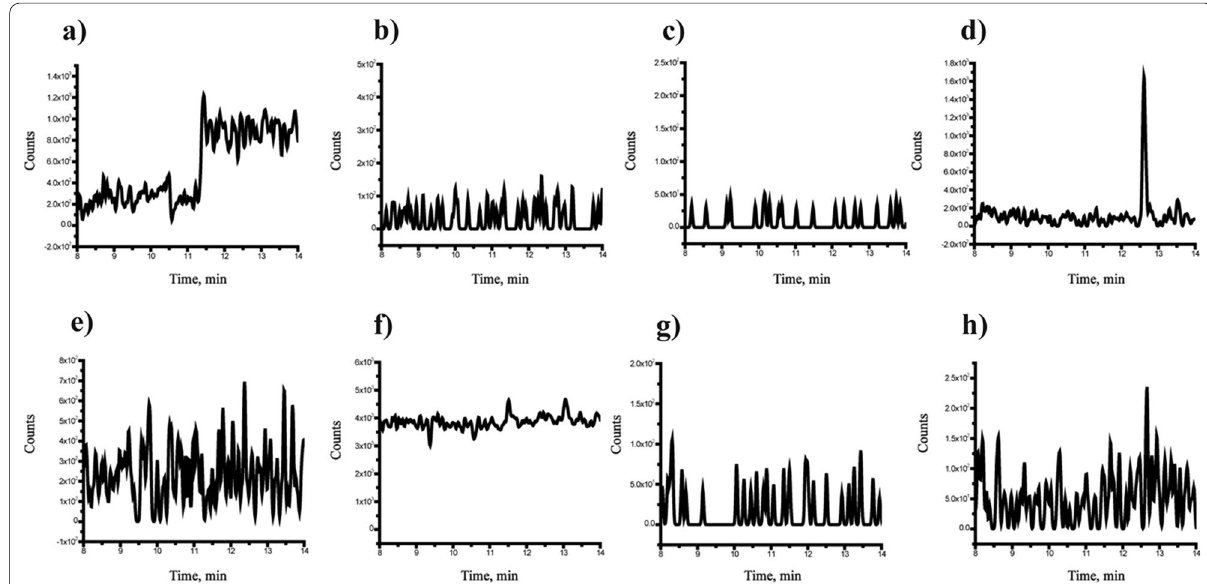
Fig. 6 Extracted ion chromatograms obtained from CE-MS analysis of Ser ( a ), Met ( b ), GSH ( c ), Glu ( d ), Asn ( e ), Val ( f ), Cystathionine ( g ), Cystine ( h ) in traditional method